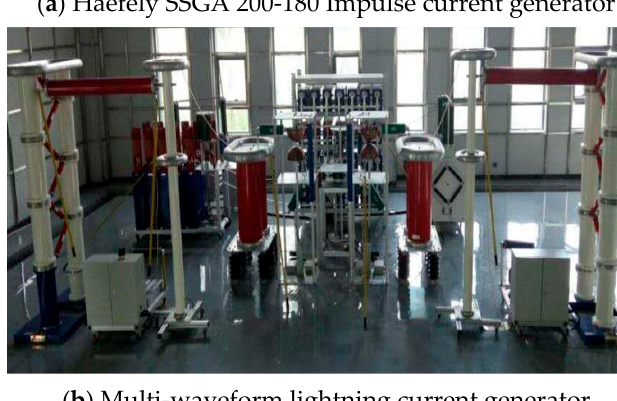
Figure 2. Artificial lightning current experiment.